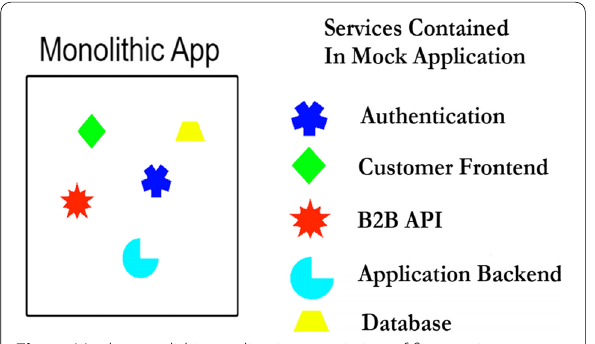
Fig. 1 Mock monolithic application consisting of five